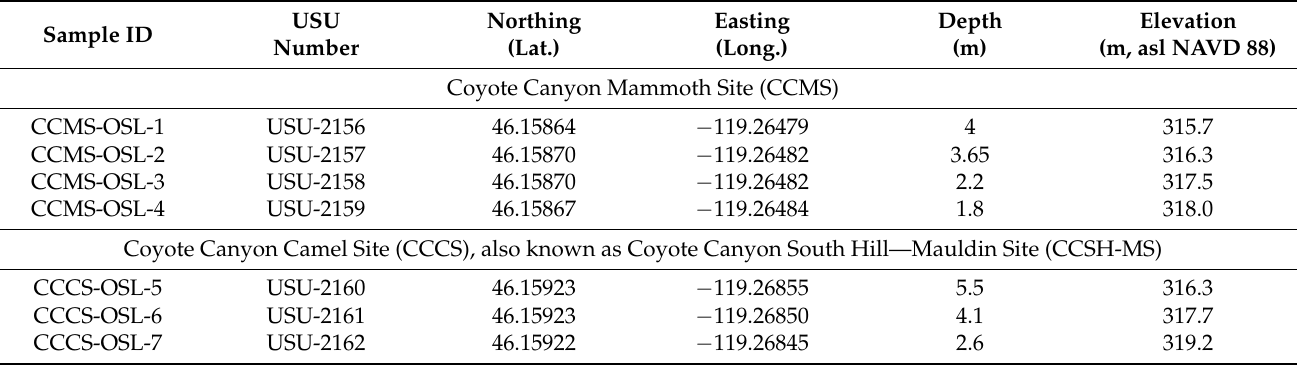
Table 2. Optically stimulated luminescence samples.